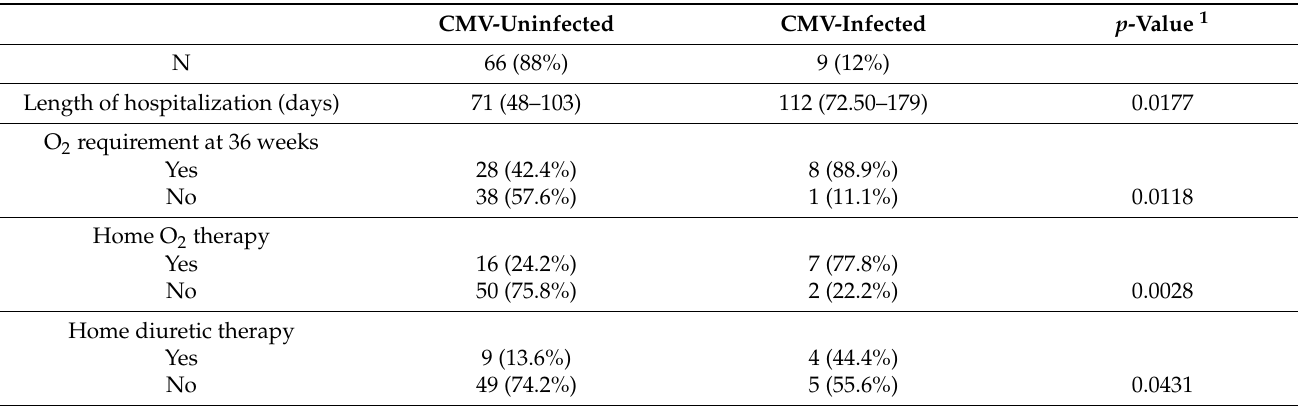
Table 7. Outcomes of infants with evidence of breast-milk-acquired CMV infections at discharge compared to controls. CMV infections were identified by retrospective analysis of infant convenience samples of whole blood (PCR) and serum (IgM assay) collected during course of hospitalization (see text for